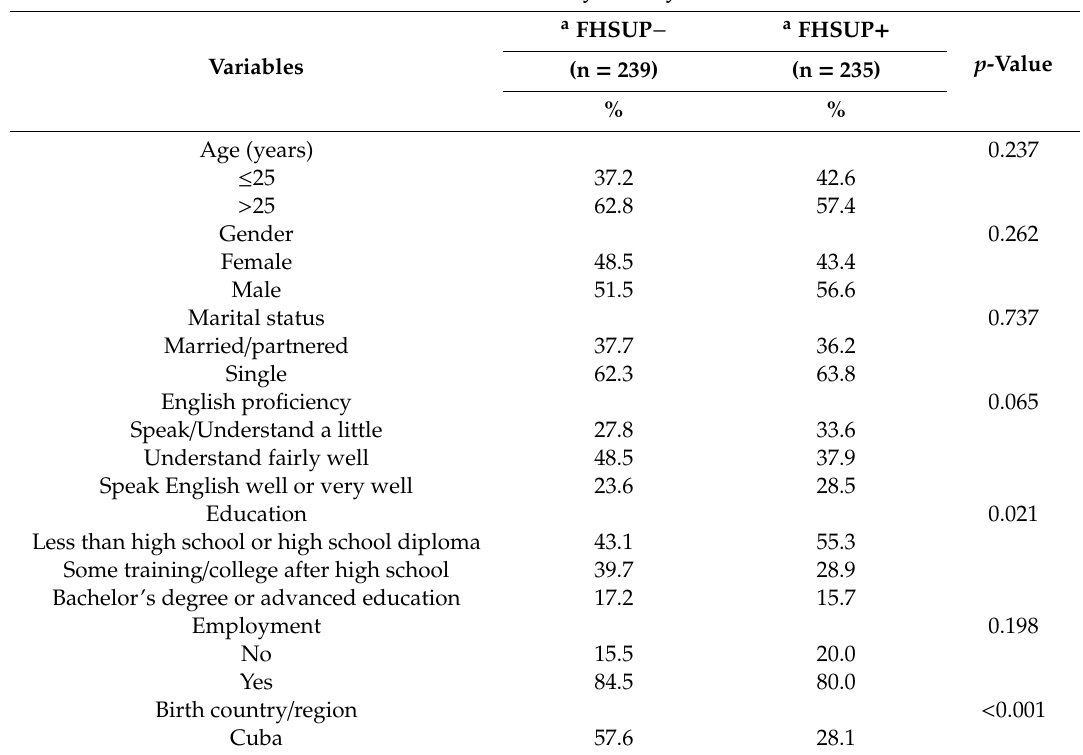
Table 2. Characteristics of recent Latino immigrants with or without family history of substance use problems (FHSUP),